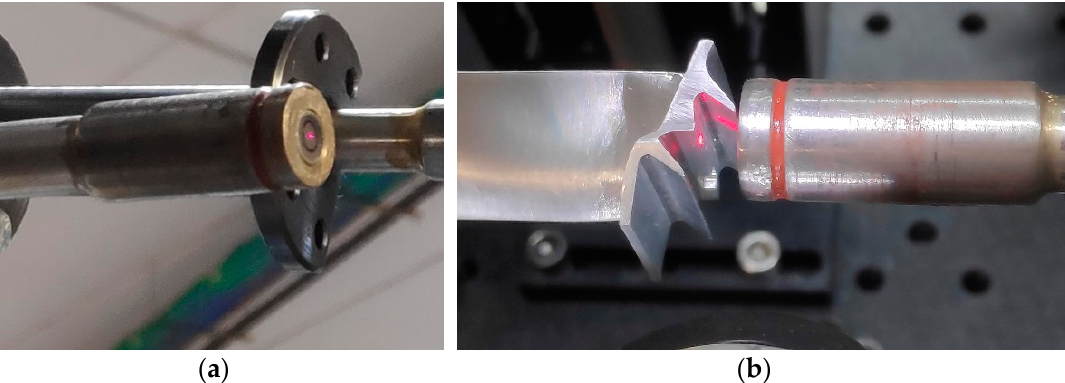
Figure 3. Detail of the optical probe ( a ) installed inside one of the adapters, and ( b ) during a laboratory calibration with a spare blade.